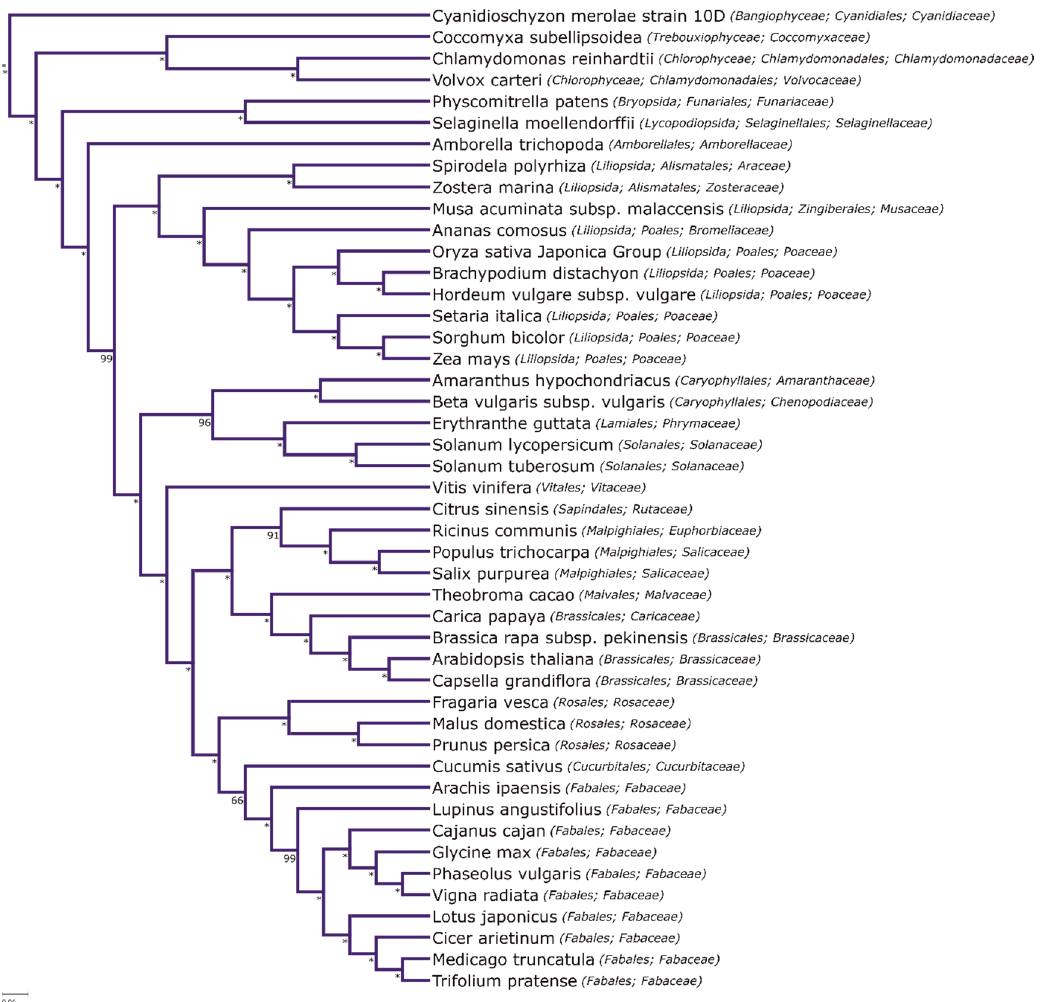
Figure 5. Maximum likelihood codon-based phylogenetic species tree of 46 reference plant genomes, based on 29 putative single-copy orthologs.